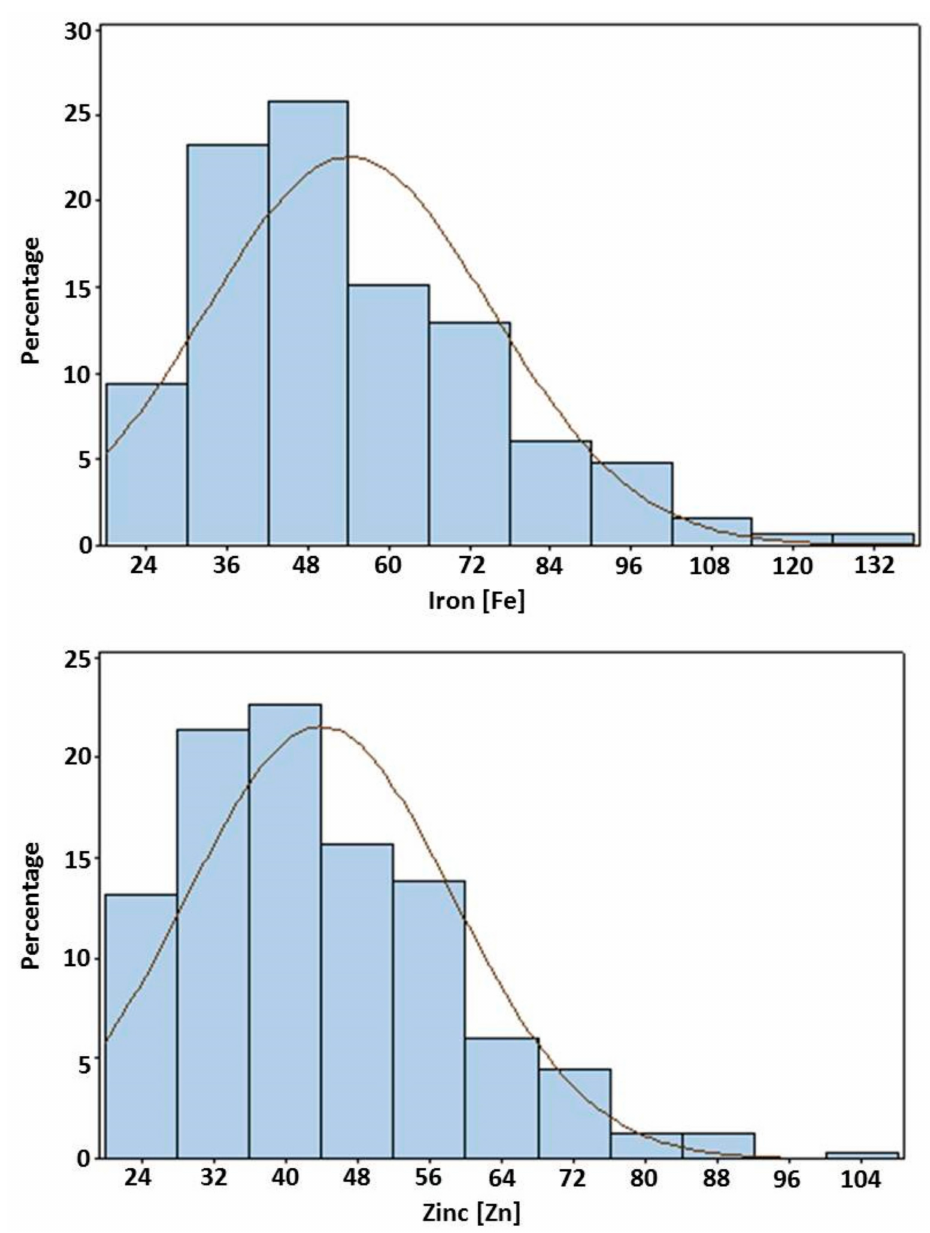
Figure 2. Frequency distribution of grain iron and zinc best linear unbiased predictions (BLUPs) among RILs of the ICMS 8511B (P1) × AIMP 92901-deriv-08 (P2)-based mapping population grown at